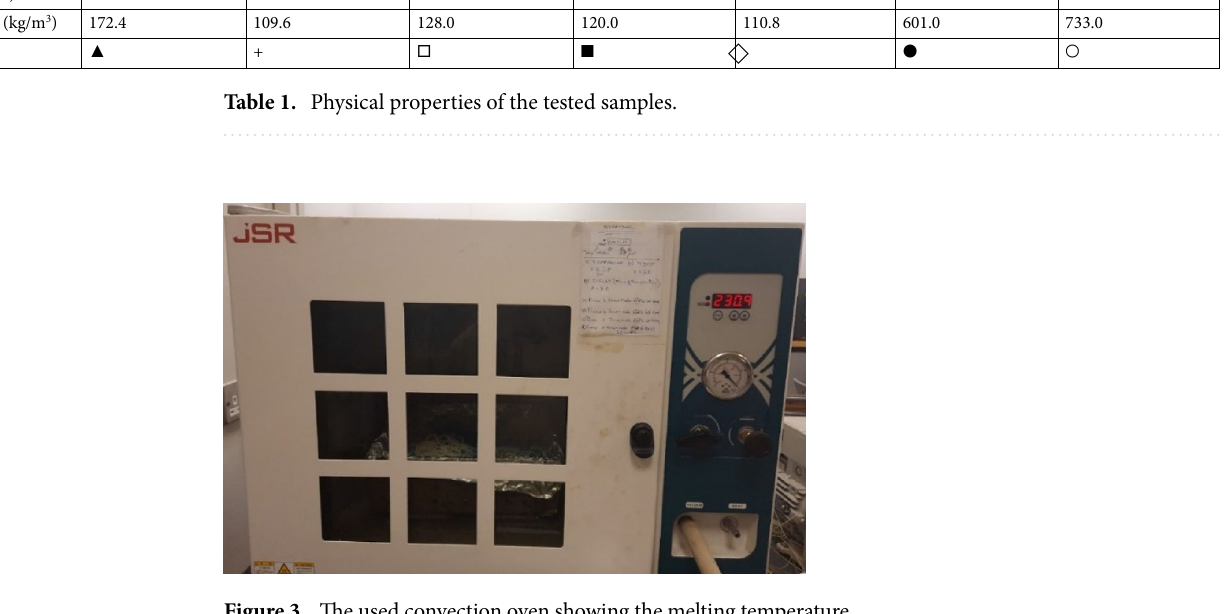
Figure 3. The used convection oven showing the melting temperature.